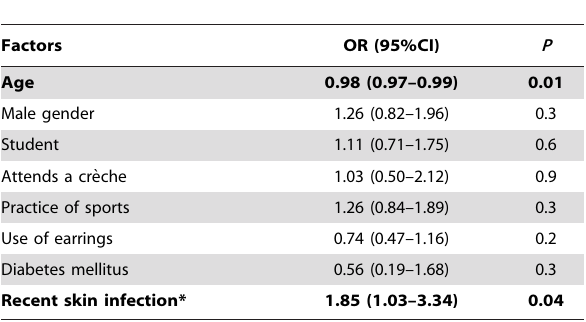
Table 2. Final model of multivariate analysis of factors associated with nasal carriage of Staphylococcus aureus among persons living in the city of Botucatu, Brazil.